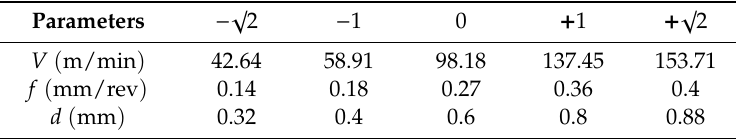
Table 1. Process parameters with their values at di ff erent levels.